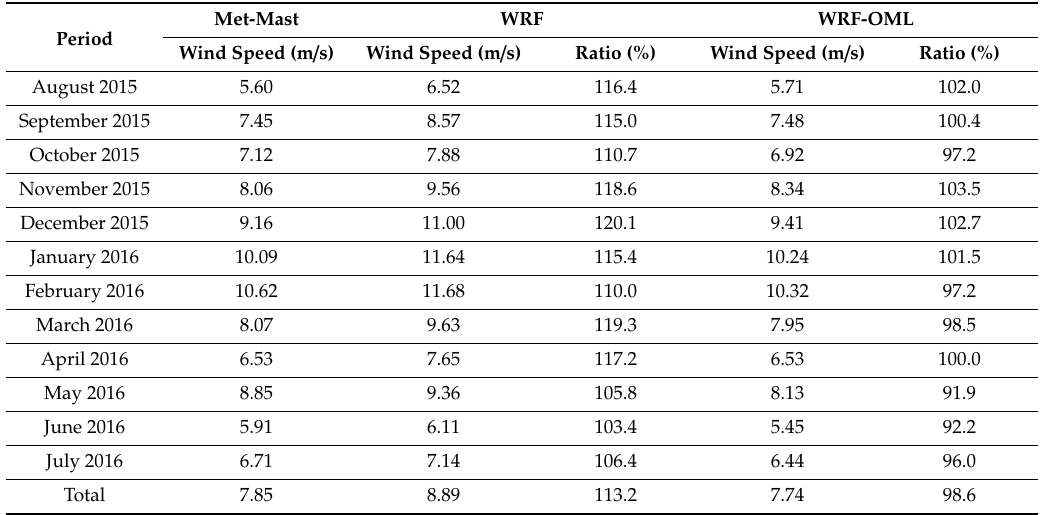
Table 4. Monthly mean wind speed from the observation data and from the models for the filtered data.